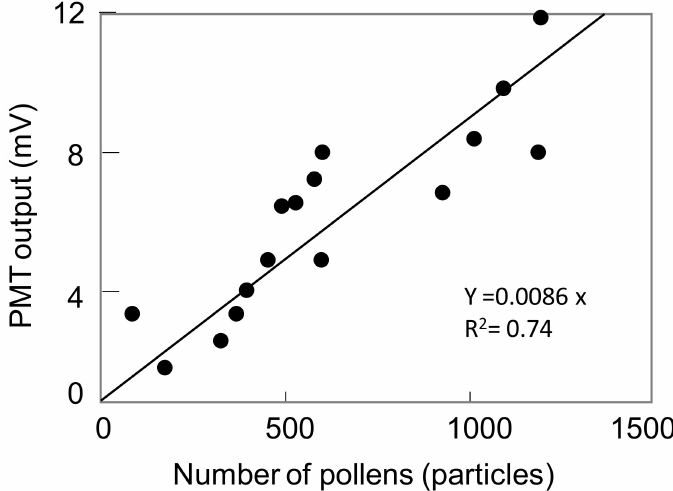
Figure 6. PMT output voltage depending on the number of